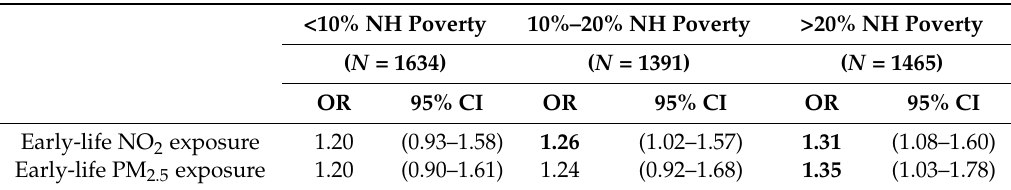
Table 4. Association of early-life pollution exposure with childhood asthma risk by neighborhood (NH) poverty, PSID-CDS,